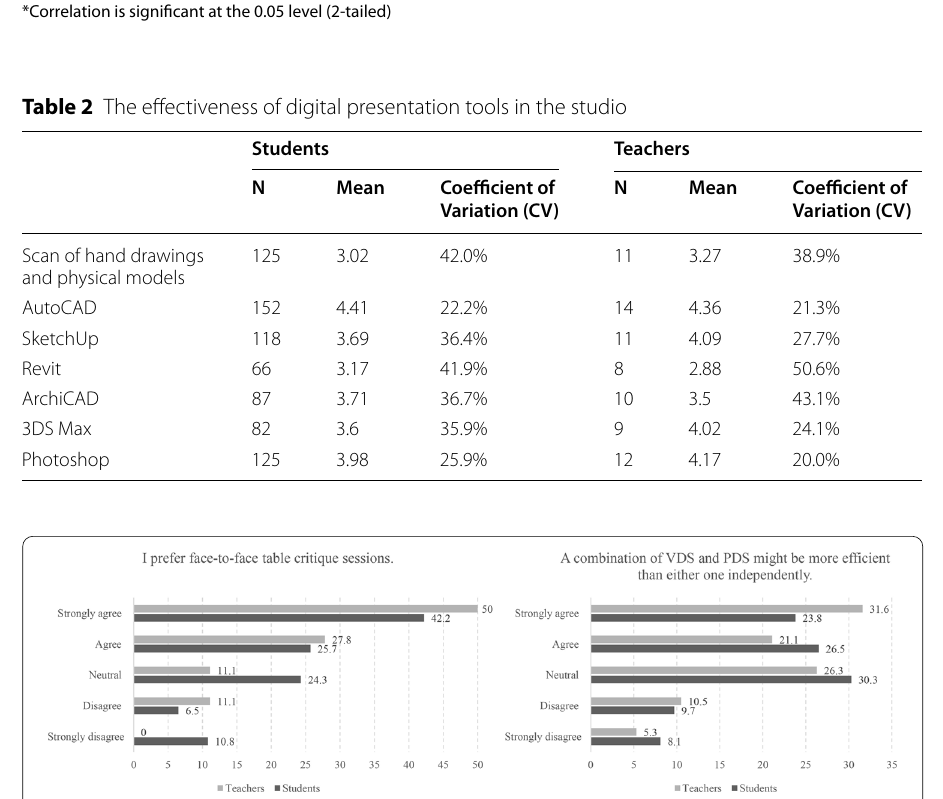
**Correlation is significant at the 0.01 level (2-tailed) *Correlation is significant at the 0.05 level (2-tailed)